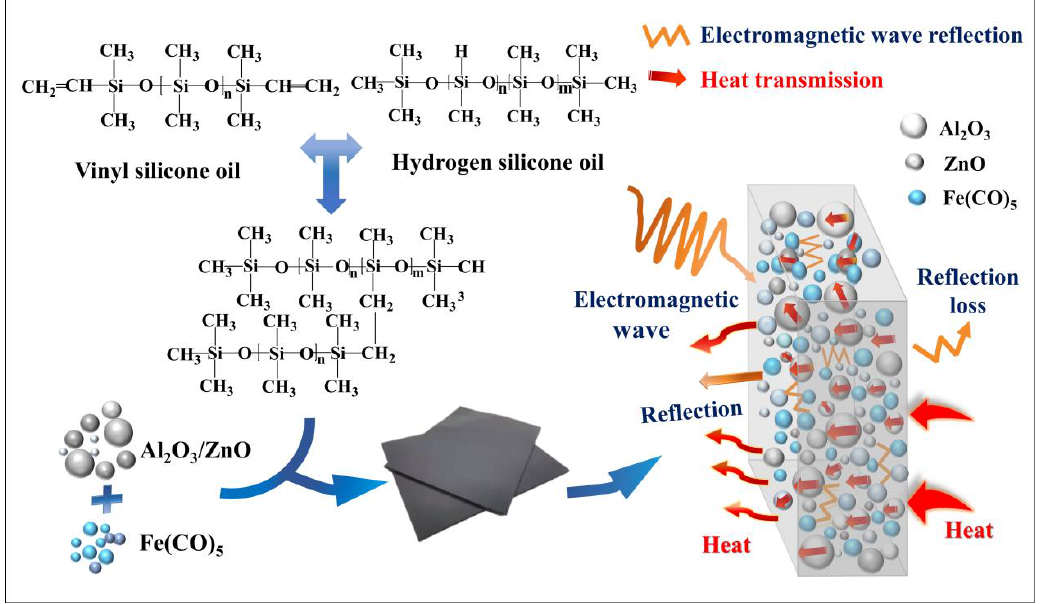
Figure 9. The reaction process of two-component silicone resin and the thermal conduction and microwave-absorbing mechanism of the composites. microwave-absorbing mechanism of the